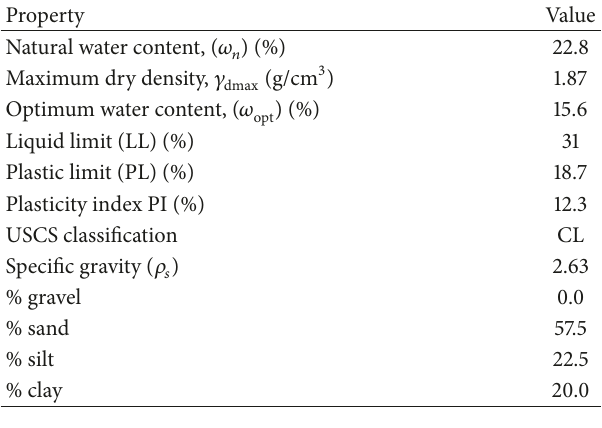
Table 1: Basic properties of original soil.